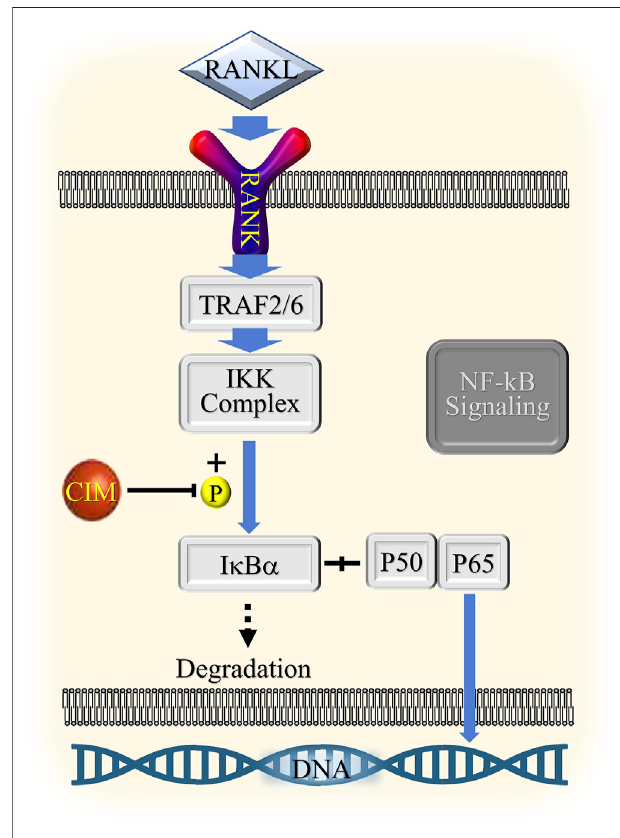
FIGURE 7 | Schematic diagram of the presumed mechanism by which CIM inhibits NF- κ B